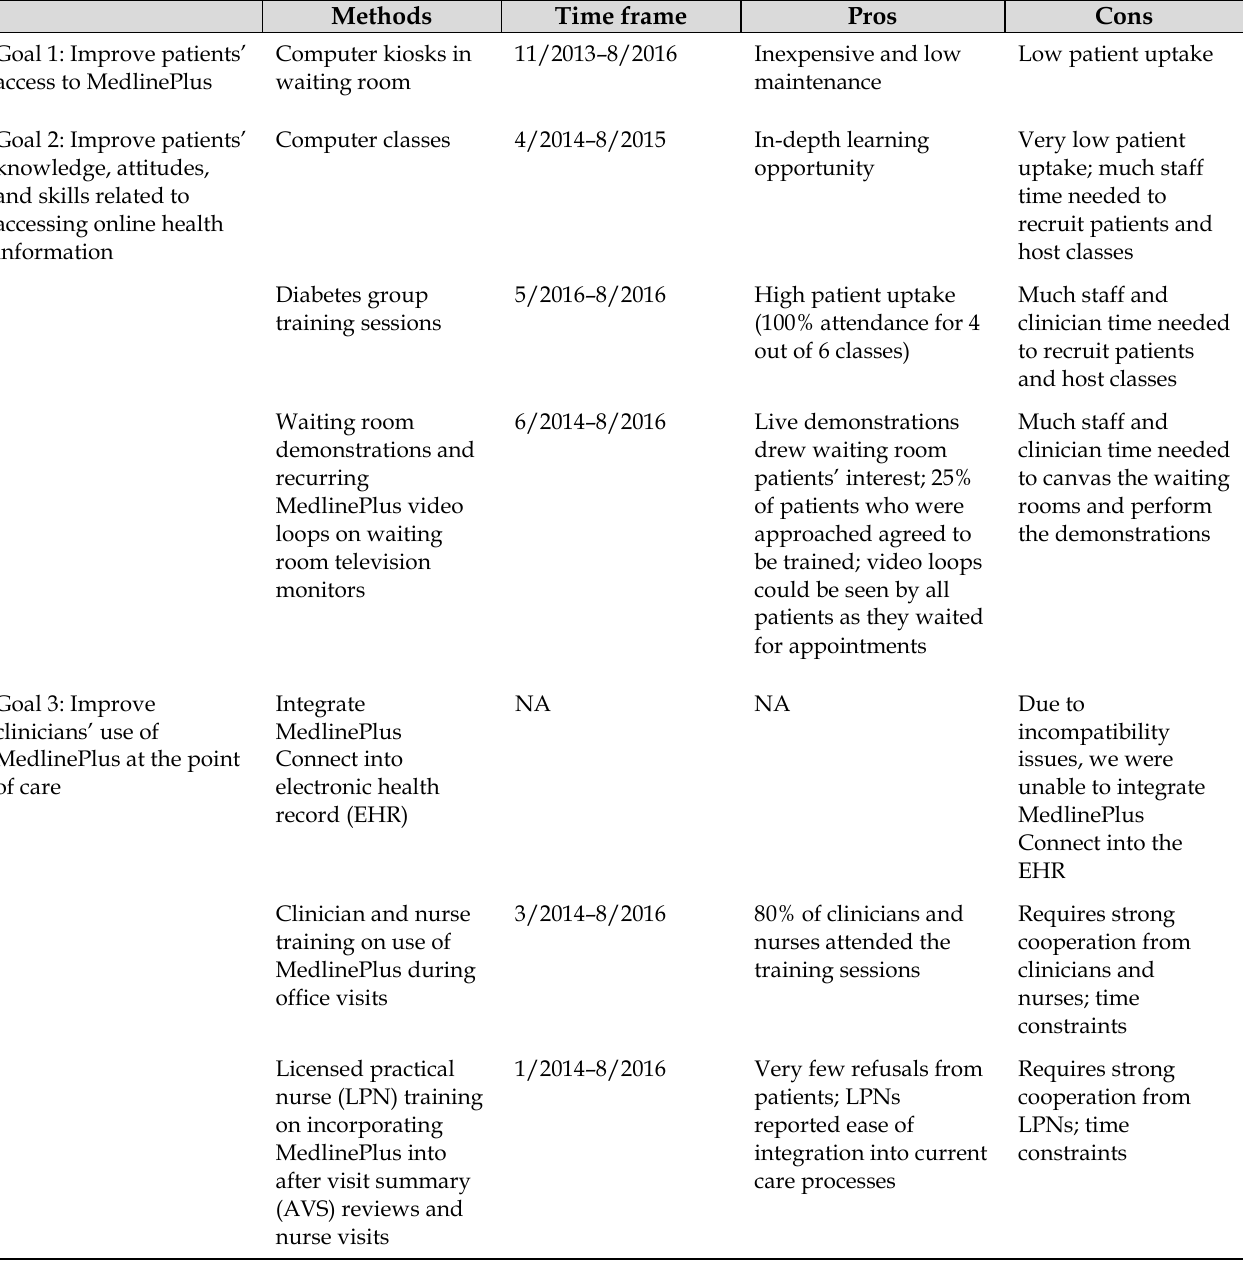
Table 1 Implementation strategies